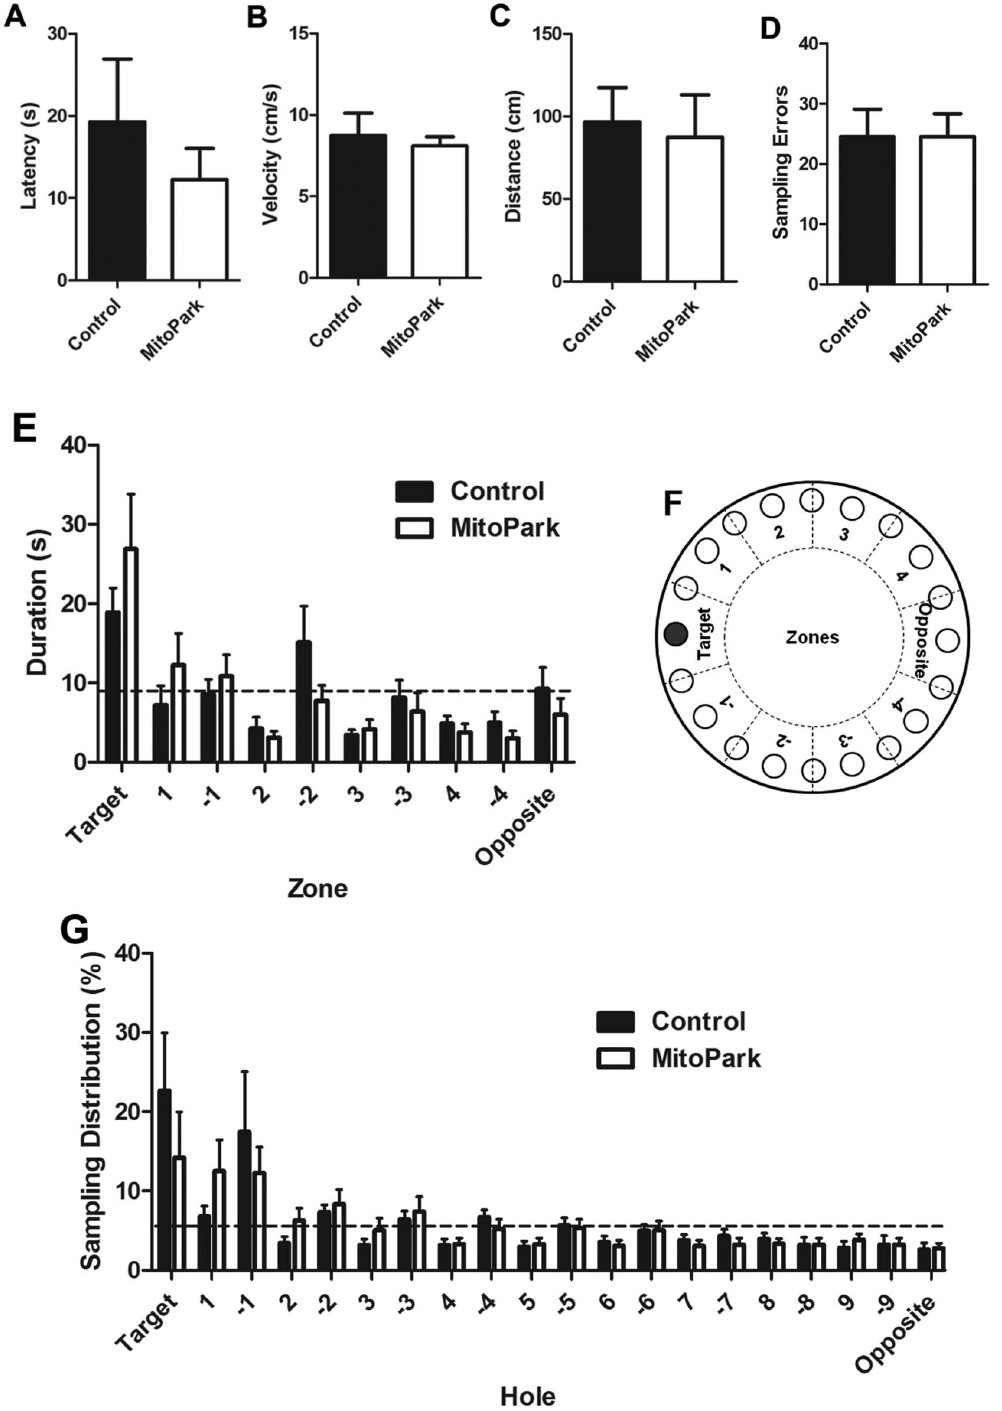
Figure 4. Behavior was assessed during a single probe trial 24 hours after the final day 4 training trial. The (A) latency to locate the correct target hole, (B) velocity during the trial, (C) distance traveled to locate the target hole and (D) the total number of sampling errors committed during the trial were measured in 8 week old MitoPark or wild-type phenotype littermate control mice. (E) The duration of time spent in each of ten identical virtual zones (schematic in F) around the perimeter of the maze was recorded, and (F) the distribution of sampling errors was recorded. Dashed lines represent the theoretical threshold if exploratory behavior were random. Data represent mean 6 SEM, (n=8 mice/group). doi:10.1371/journal.pone.0071341.g004 and memory task often regarded as a dry version of the more well- on the perirhinal and entorhinal cortices [23,24]. Interestingly, known Morris water maze. Novel object recognition is dependent distinct subsets of VTA dopamine neurons project to these regions,